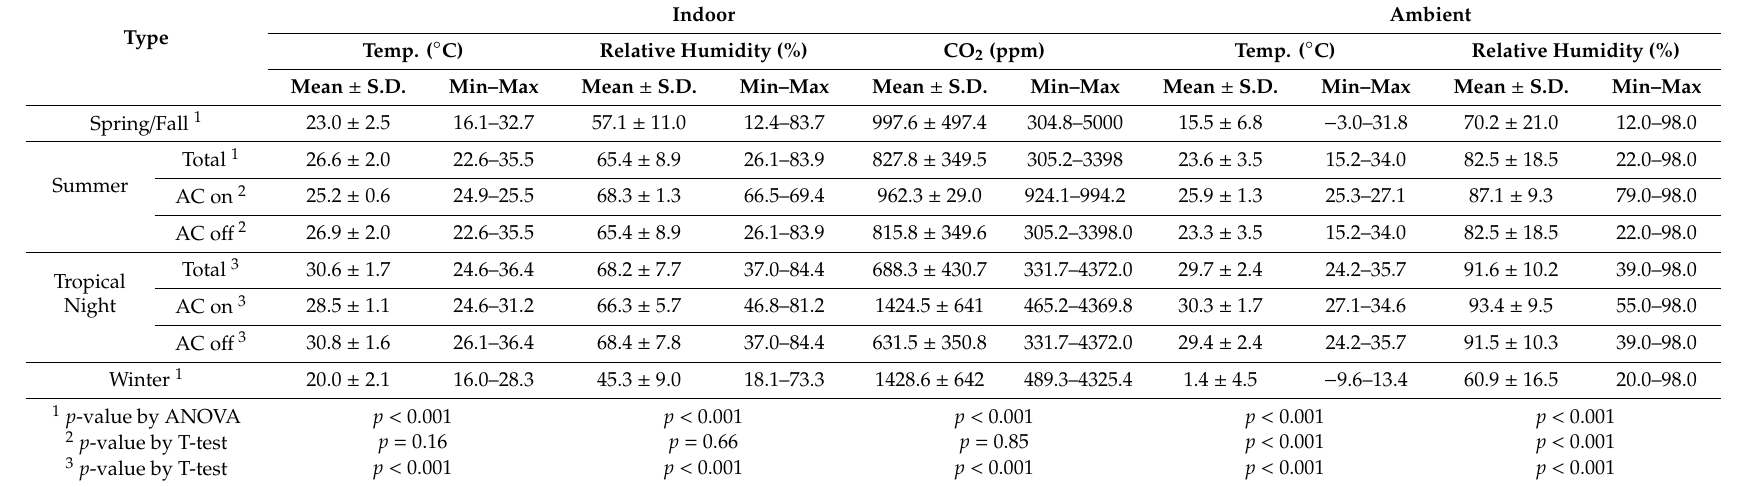
Table 3. Seasonal distribution of hourly average indoor and ambient temperature, humidity, and CO 2 in